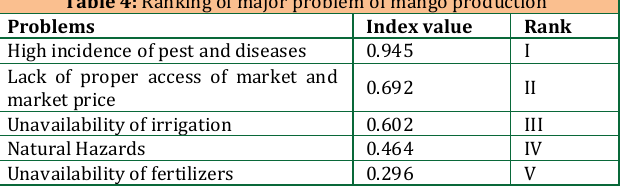
Table 4: Ranking of major problem of mango production